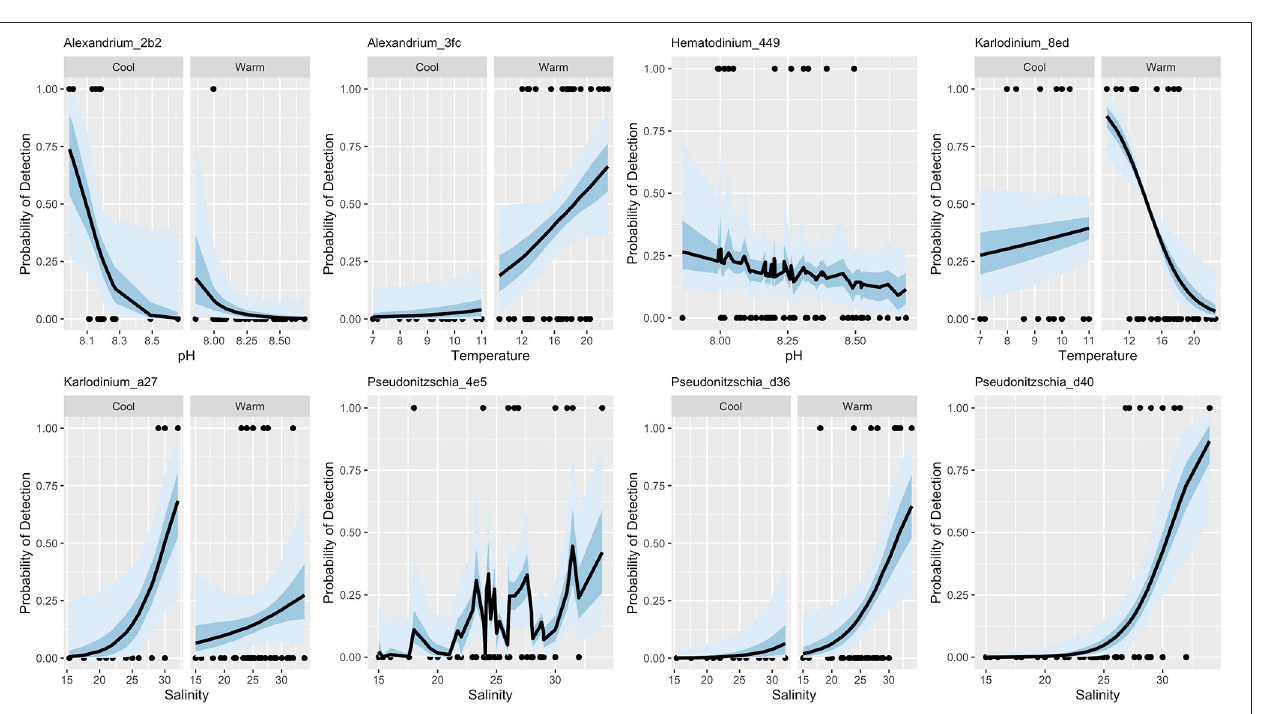
FIGURE 3 | Best-fit logistic models for eight focal algal lineages. Here, probability of detection is shown as a function of the single most influential environmental variable in the model, along with overall model means (lines) and 50 and 95% credibility intervals (shaded areas). Where two-panel figures are shown for a taxon, the best-fit model included a slope term that varied by